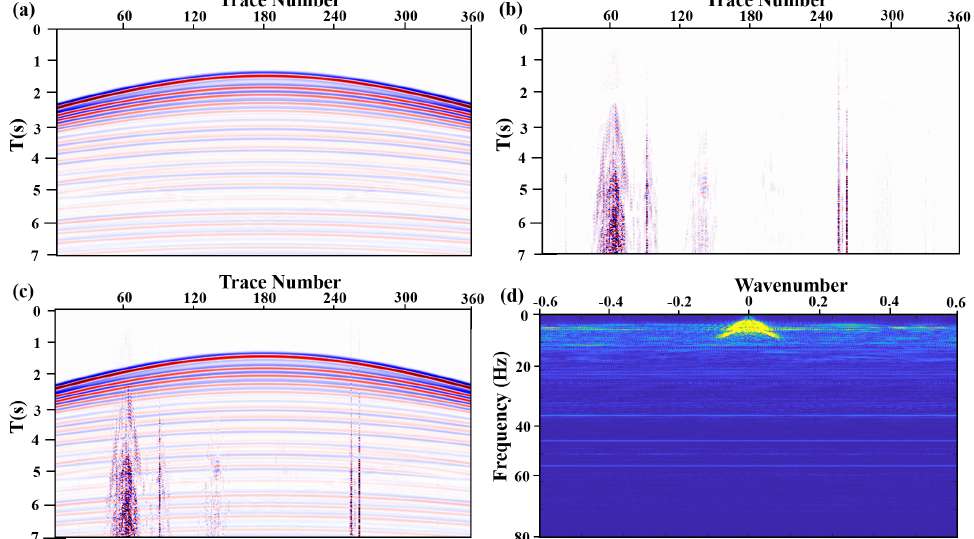
Figure 8. ( a ) Synthetic data without noise; ( b ) traffic noise; ( c ) synthetic data after adding noise to ( a ); ( d ) the f-k spectra of ( c